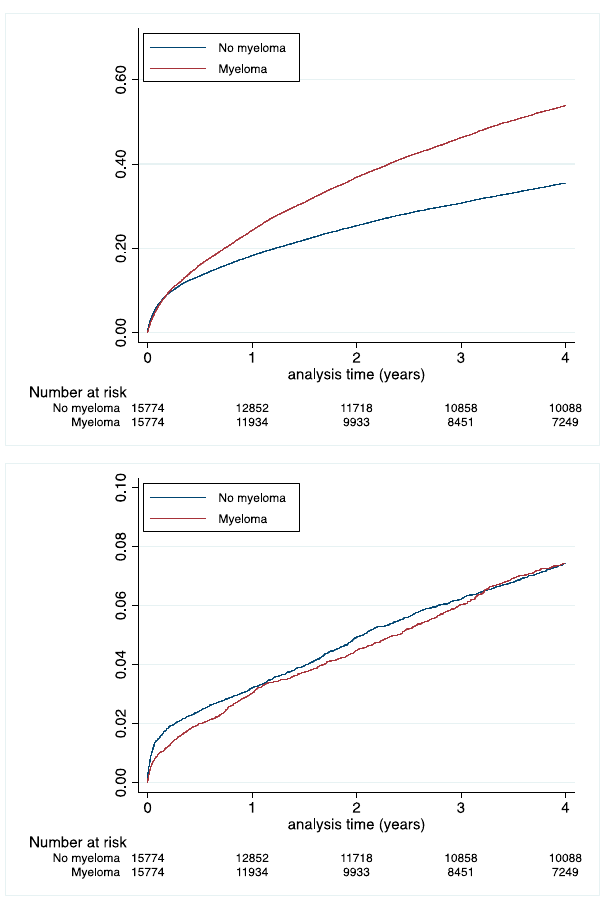
Figure 2. Cumulative incidences of all-cause death ( top panel) or cardiovascular death ( lower panel) in the matched population. Incidence rates of MI and ischaemic stroke were significantly lower in MM patients: 0.86 vs. 0.97%/y; p = 0.03 and 0.85 vs. 1.10%/y; p < 0.0001, respectively (Table 3 and Figure 3). In contrast, MM patients had a higher incidence rate of hospitalization for major and intracranial bleedings: 3.61 vs. 2.24%/y; p < 0.0001 and 1.03 vs. 0.84%/y; p = 0.0005, re- spectively (Table 3 and Figure 4). The competing risk analysis confirmed the lower risks